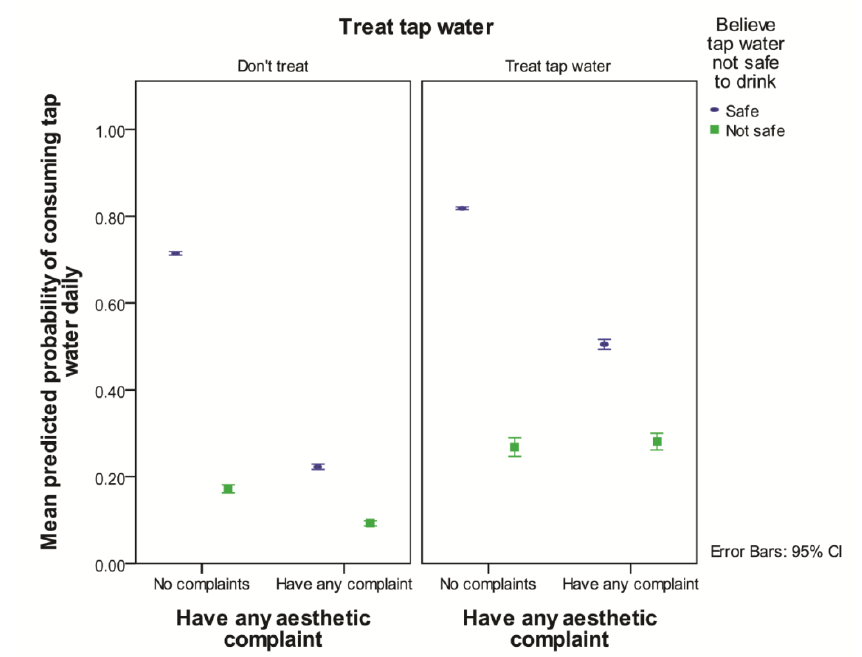
Figure 4. Predicted probability of consuming tap water daily by presence of aesthetic complaint and the belief that tap water is not safe to drink, separated by in-home treatment of tap water averaged over all whether household had experienced a water advisory and length of time resided in